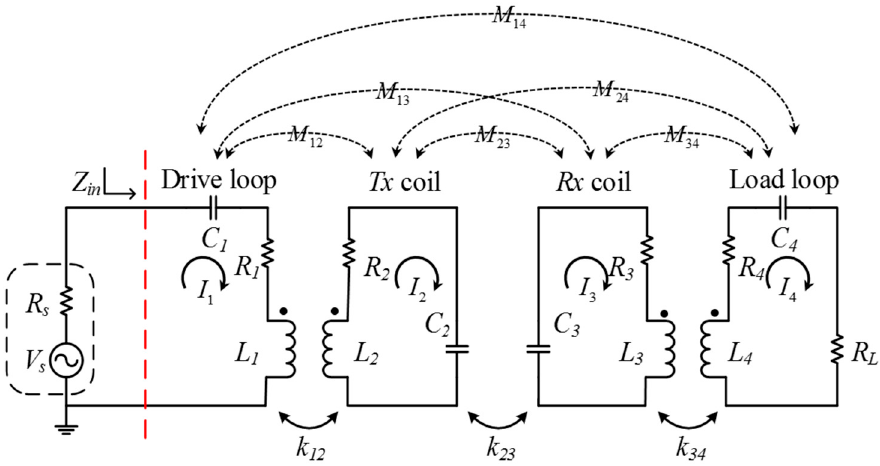
Figure 1. Equivalent circuit model of the four-coil WPT system .